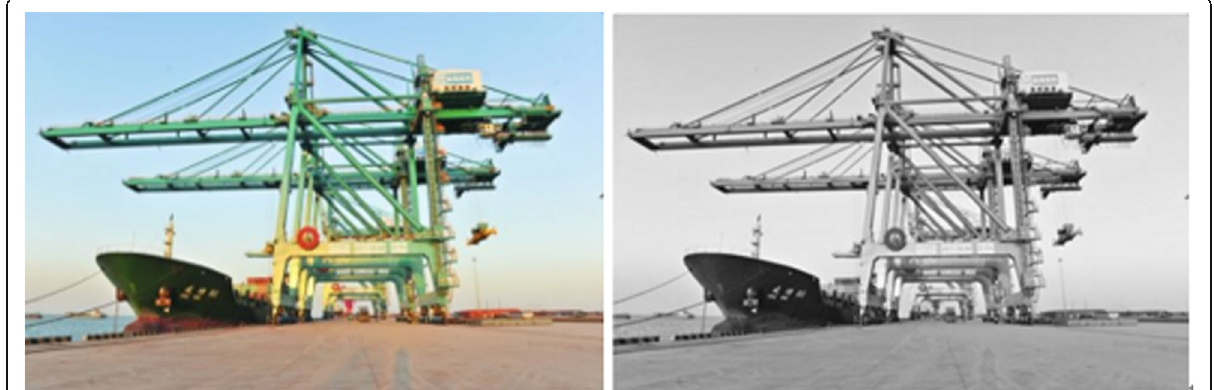
Fig. 2 Color image grayscale. a Color image. b Grayscale